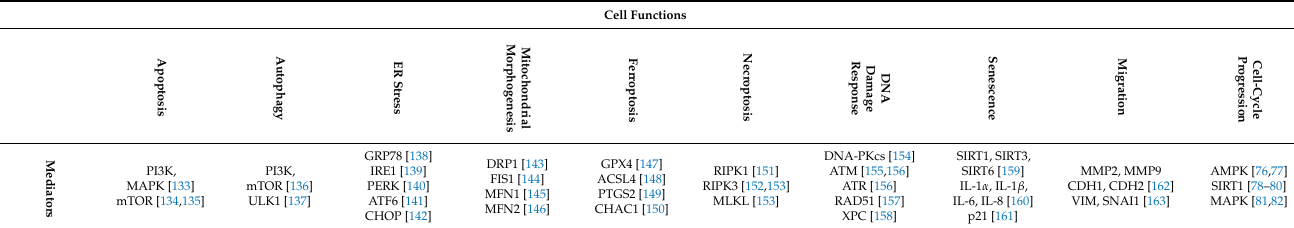
Table 2. AKT regulates cell functions via several